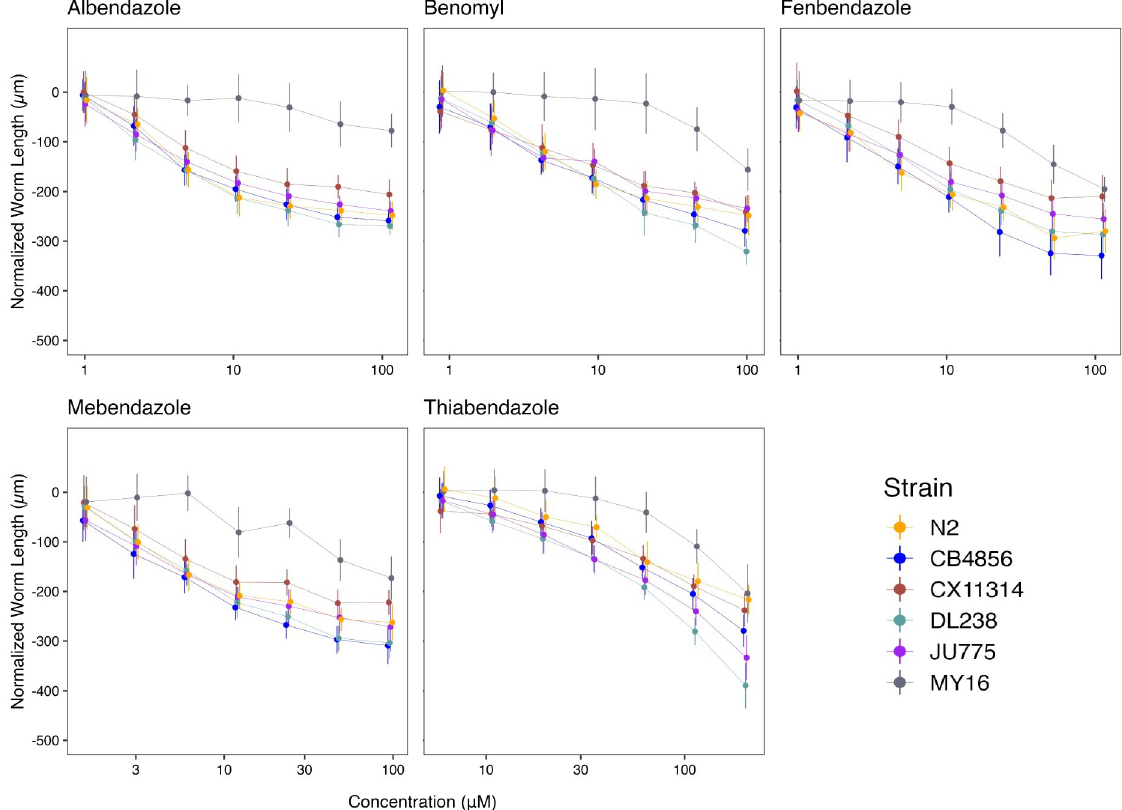
Fig 2. Dose-response curves for benzimidazoles (BZs). Normalized animal lengths (y-axis) are plotted for each strain as a function of the dose of benzimidazole supplied in the high-throughput phenotyping assay (x-axis); Albendazole, Benomyl, Fenbendazole, Mebendazole, and Thiabendazole. Strains are denoted by color. Lines extending vertically from points represent the standard deviation from the mean response. Statistical normalization of animal lengths is described in Methods .